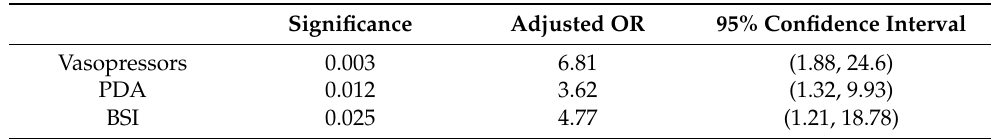
Table 3. Multivariate analysis by stepwise forward test for prediction of acute kidney injury in very low birth weight infants.